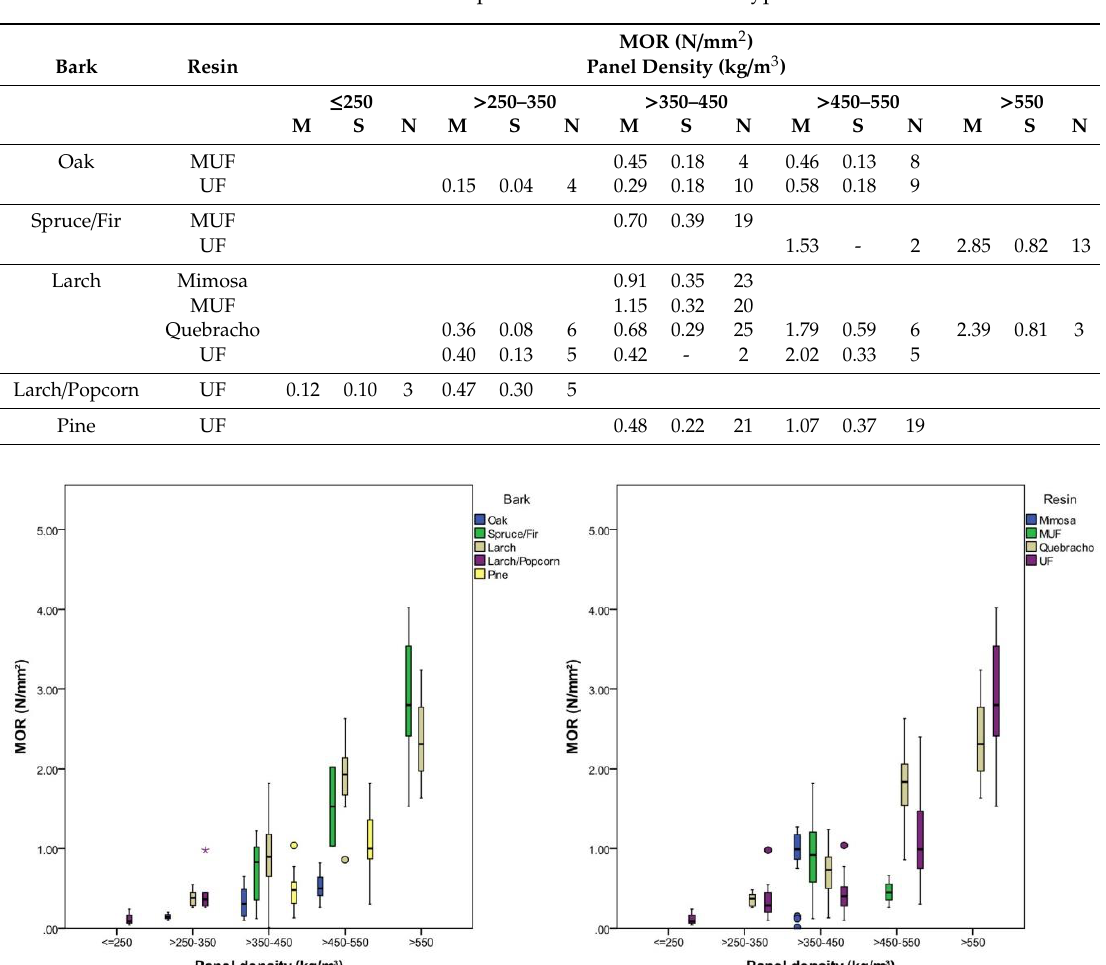
Table 5. MOR dependent on bark and resin type.